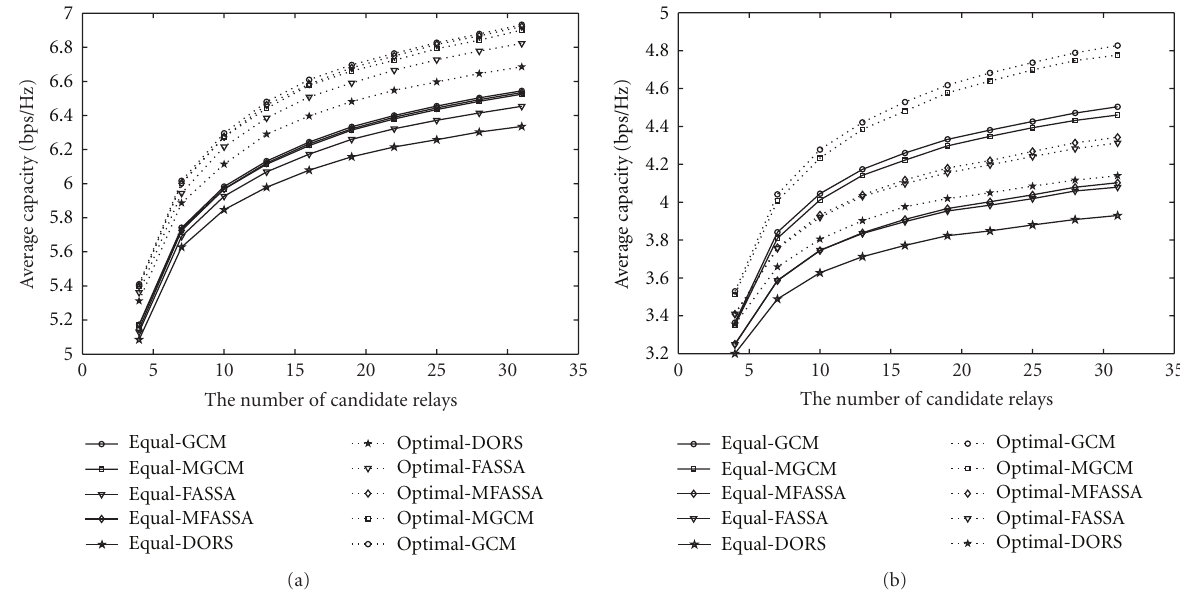
Figure 2: System-capacity performance comparisons of various relay antenna selection algorithms in terms of the number of candidate relays N for an AF-MIMO multiple-relay system with the use of [ N S , N R , N D , K ] = [10,2,10,4] and the (a) low and (b) high spatial-correlation scenarios under either an optimal or equal-power